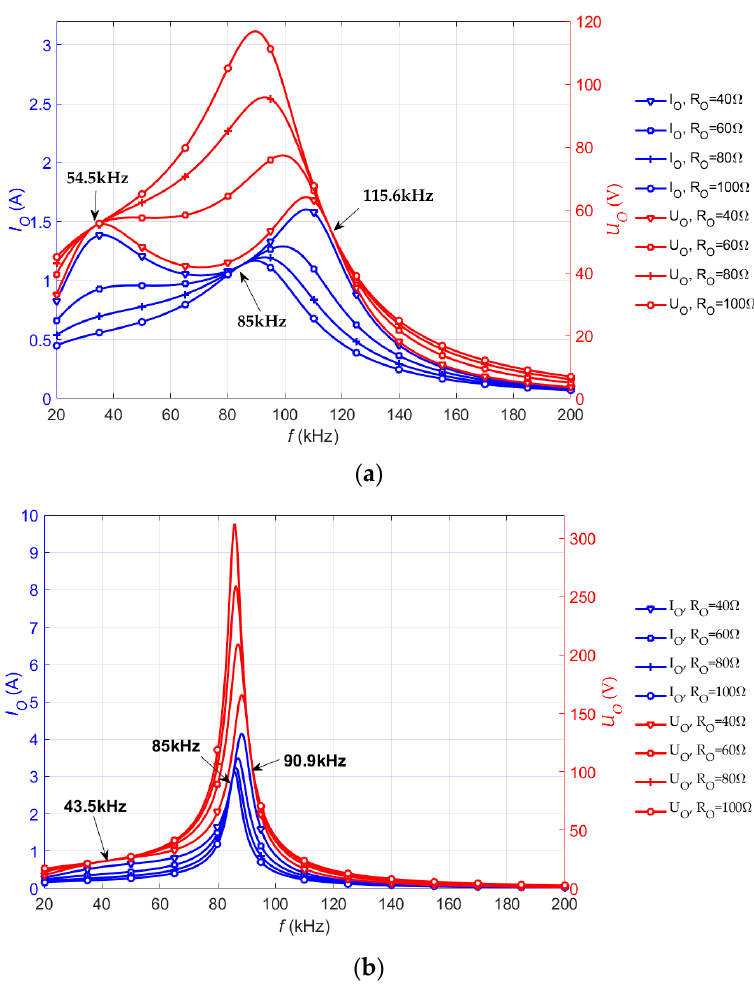
Figure 3. Relationship between I o, U O and f . ( a ) λ 3 = λ 2 = 1- λ 1 = 0.72; ( b ) λ 3 = λ 2 = 1- λ 1 = 0.28. Energies 2019 , 12 , x FOR PEER REVIEW